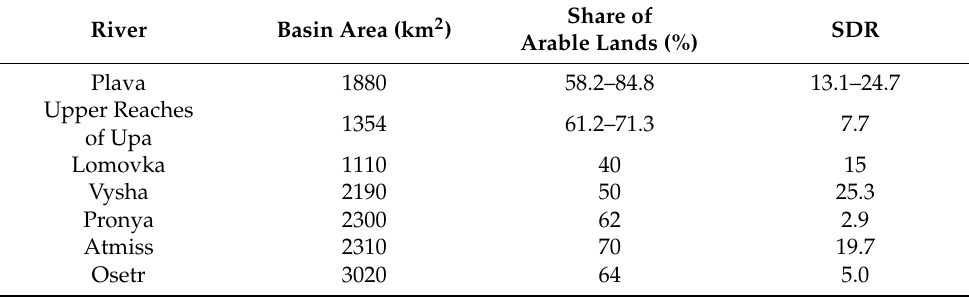
Table 7. Comparison of SDR values of Plava River and upper reaches of Upa with river basins of Oka River system [147].